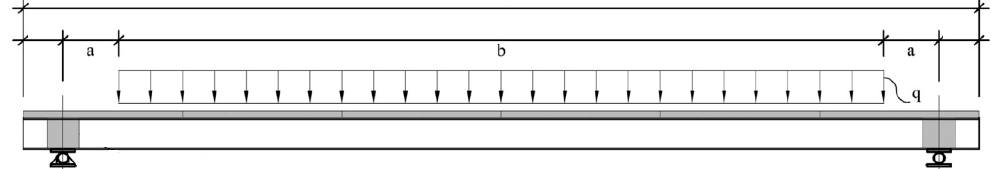
Figure 16. Load configuration of creep tests. Units in mm. Table 11. Parameters used to determine the flexural stiffness of the cross-section. Elemental Areas